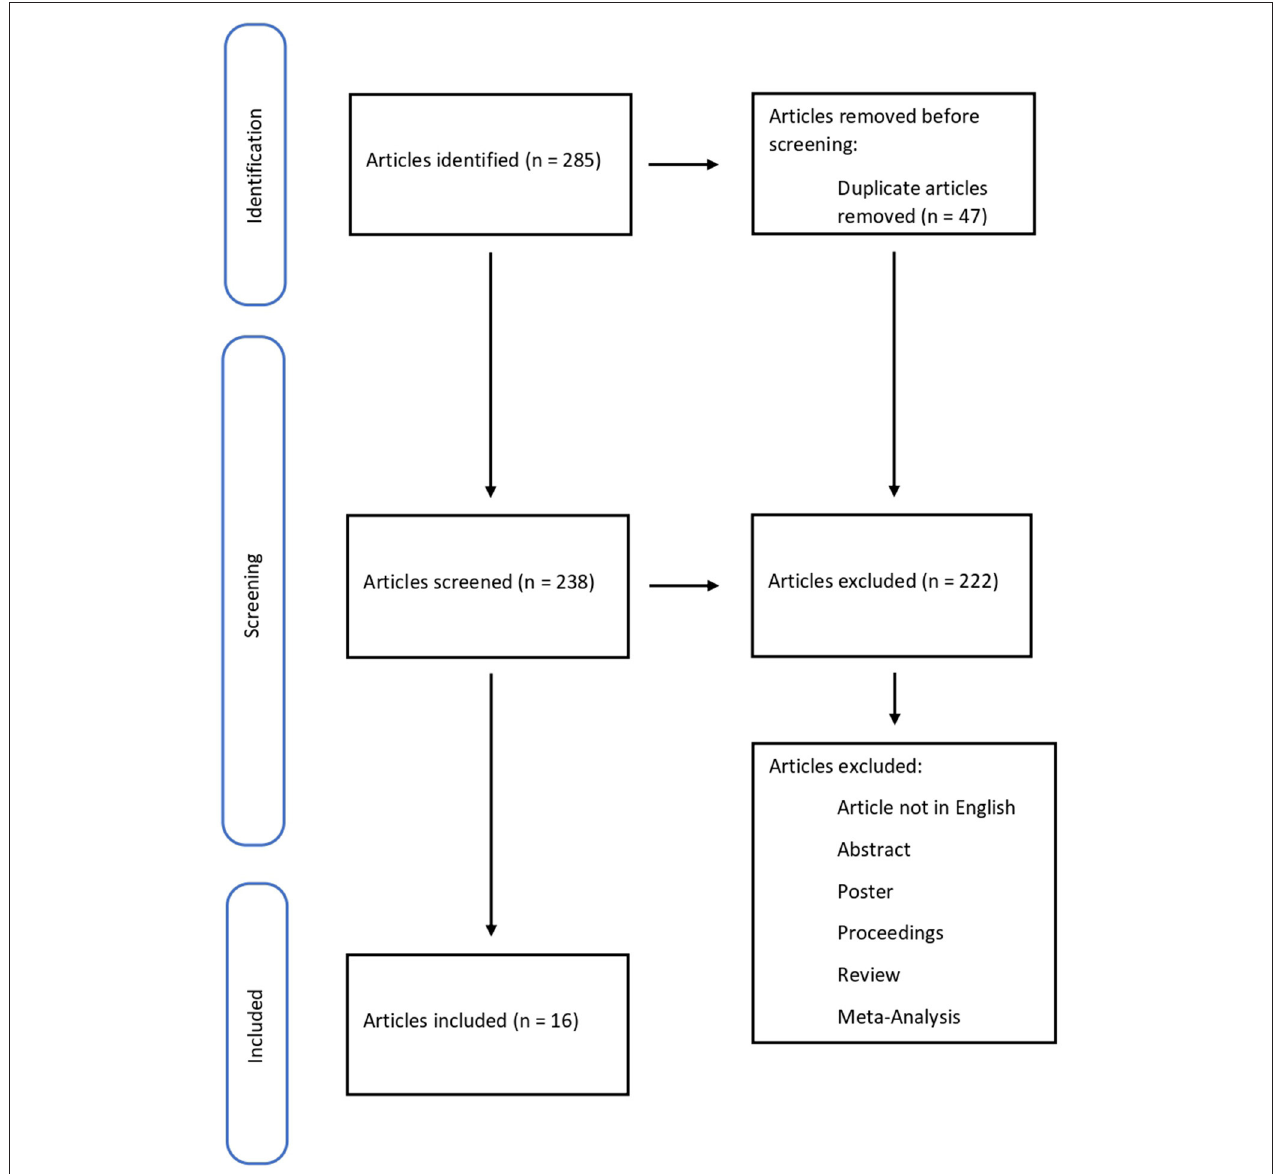
FIGURE 1 | Flow diagram illustrating studies included in and excluded from this systematic